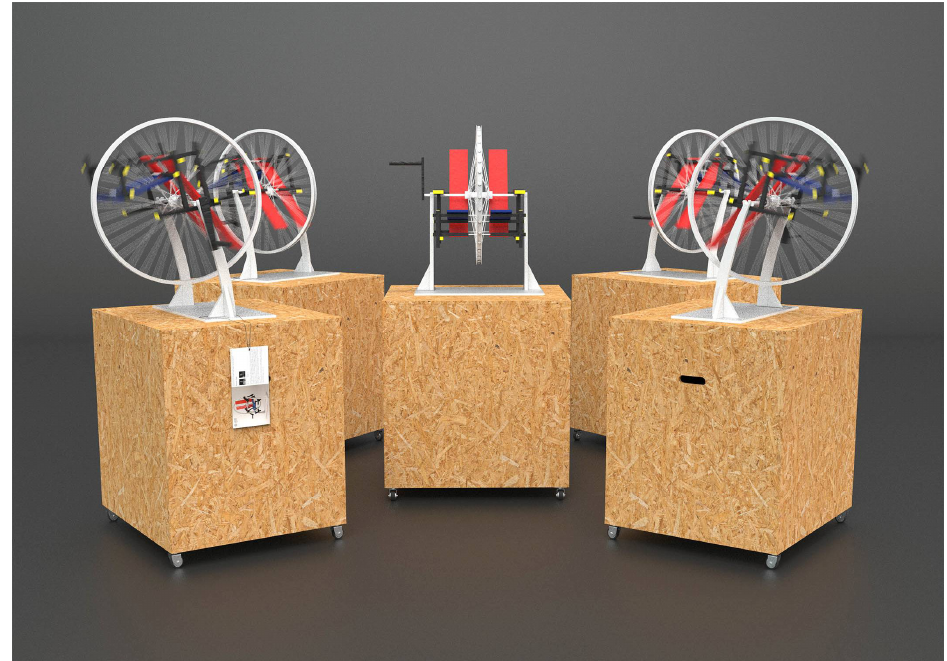
Figure 1. Martina Lucchin, Piera Macedonio: “ Duchampe and Rietveld